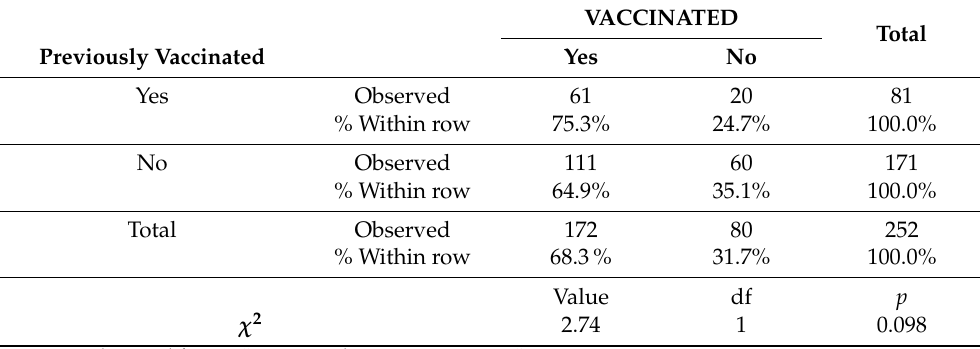
Table 6. Previous voluntary vaccination and decision to vaccinate against COVID-19.